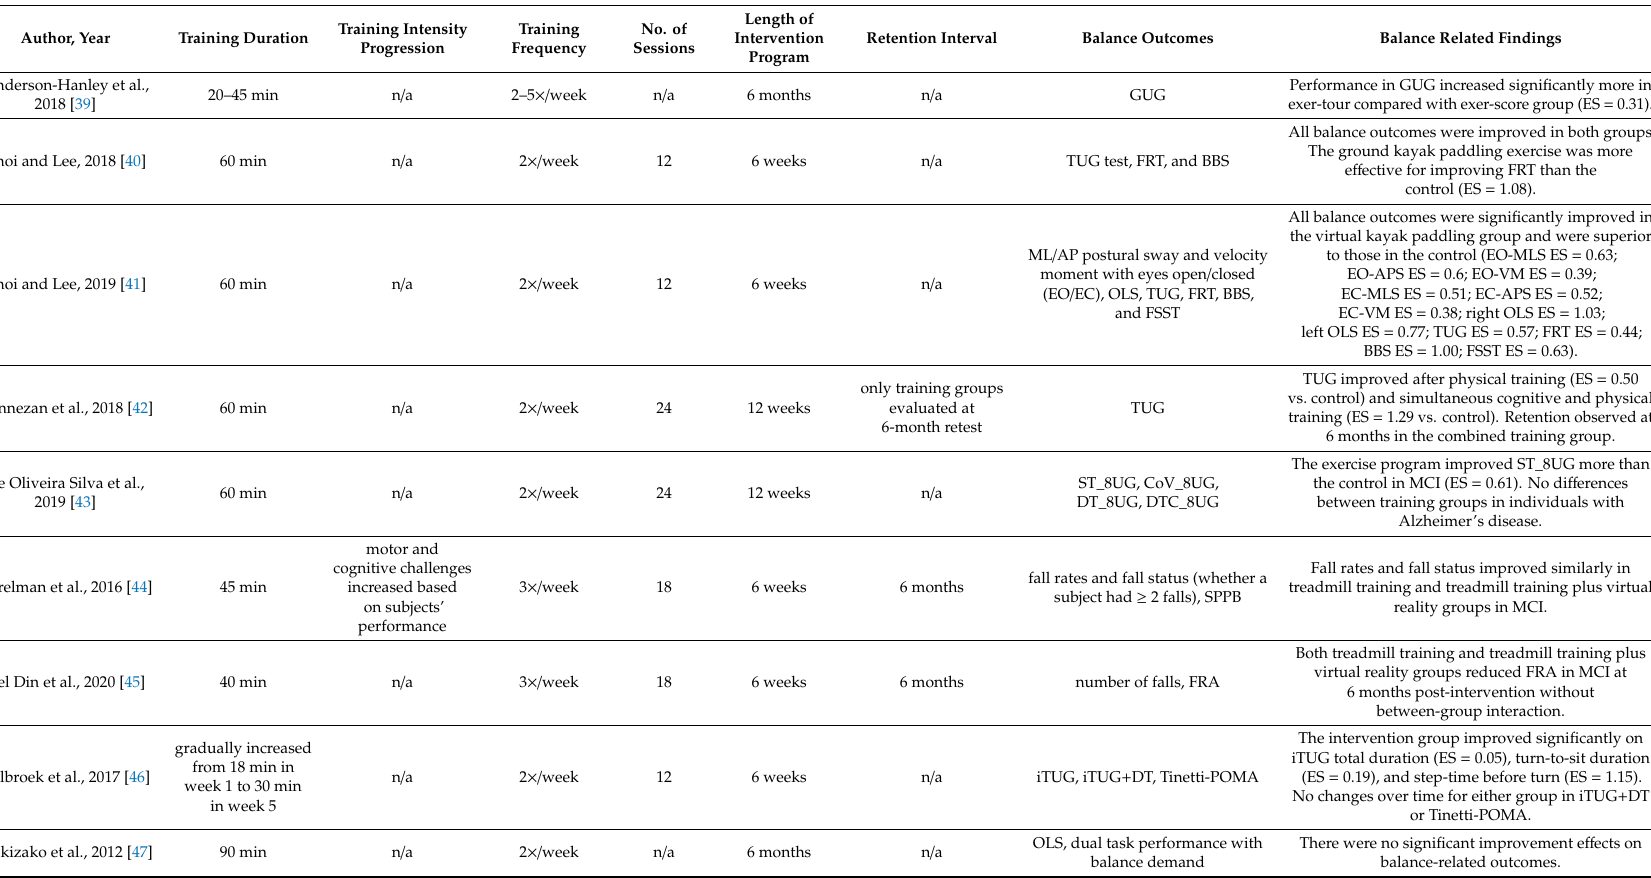
Table 2. Training dosage, intensity, retention, balance outcomes, and balance related findings in the RCTs included. Abbreviations: MCI mild cognitive impairment; ES e ff ect size (Hedge’s g); GUG get-up and go; TUG timed up and go; FRT functional reach test; BBS berg balance scale; OLS one-leg stance; FSST four square step test; 8UG 8-foot up and go test; ST_8UG single task in 8UG; CoV_8UG coe ffi cient of variation of ST_8UG; DT_8UG dual task in 8UG; FRA falls rate to activity; SPPB short physical performance battery; HR harmonic ratio; FES-I fall e ffi cacy scale-international; BESTest balance evaluation systems test; PPA physiological profile assessment; ABC activities-specific balance